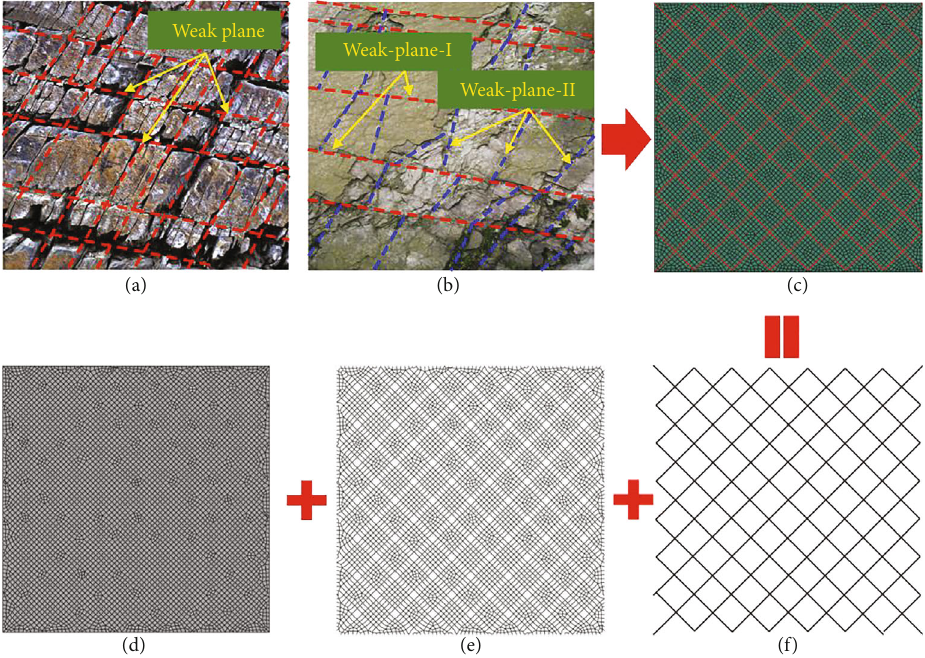
Figure 1: Shale outcrop with conjugate cross distribution of weak planes and its model grid diagram. (a) Sanmin shale outcrop. (b) Shale outcrop of Xiaoheba formation. (c) Conjugate weak plane shale. (d) Matrix unit. (e) Matrix cohesive unit. (f) Conjugate weak-plane cohesive